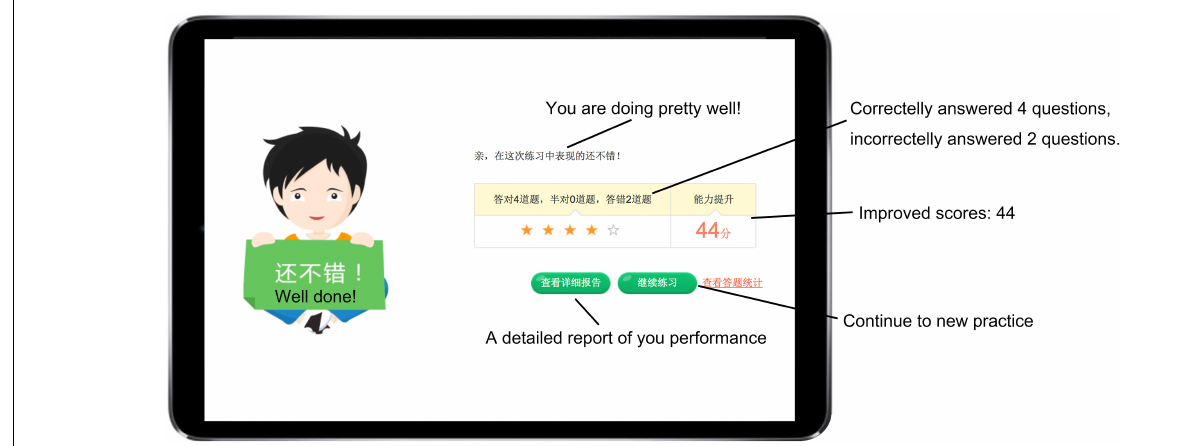
FIGURE 6 | User interface of the progress recoding.